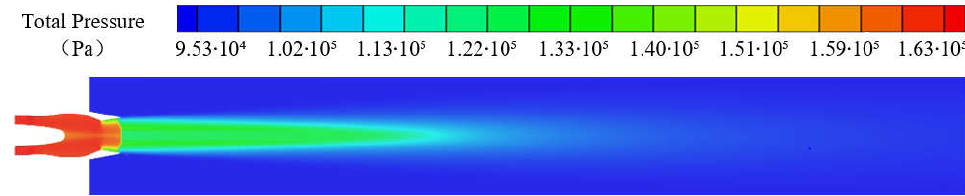
Figure 5. Cloud chart of Mach.